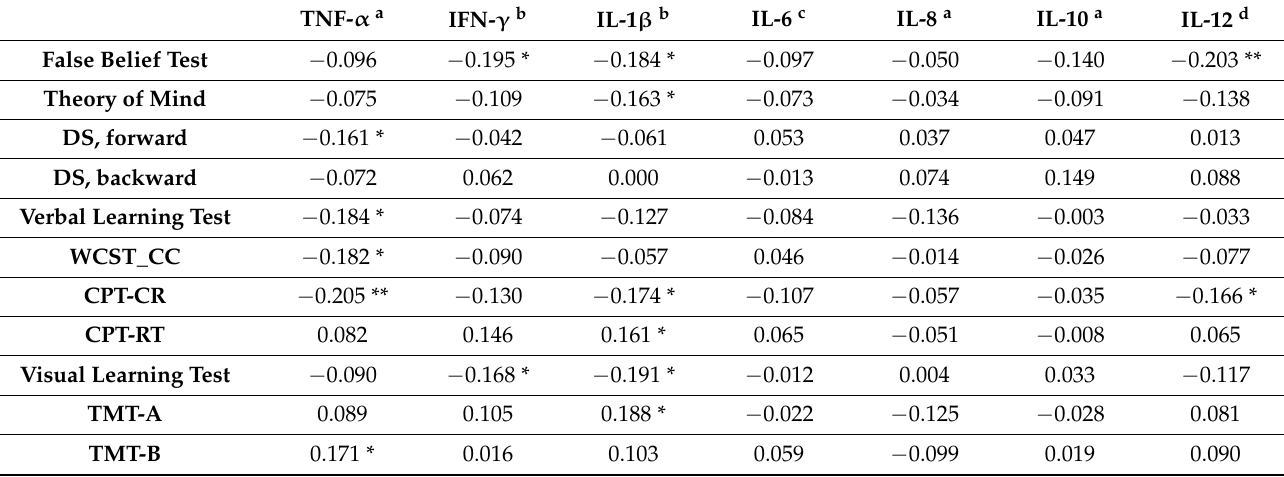
Table 3. Correlation coefficients between cytokines and cognitive